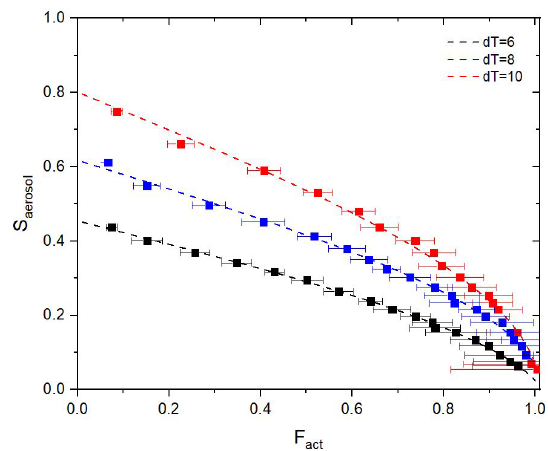
Figure 8. Experimental data (square dot with error bar) and fit- ting curves (dashed lines) for three different d T conditions: d T = 6 (black), 8 (blue), and 10K (red). Ammonium sulfate particles are used for